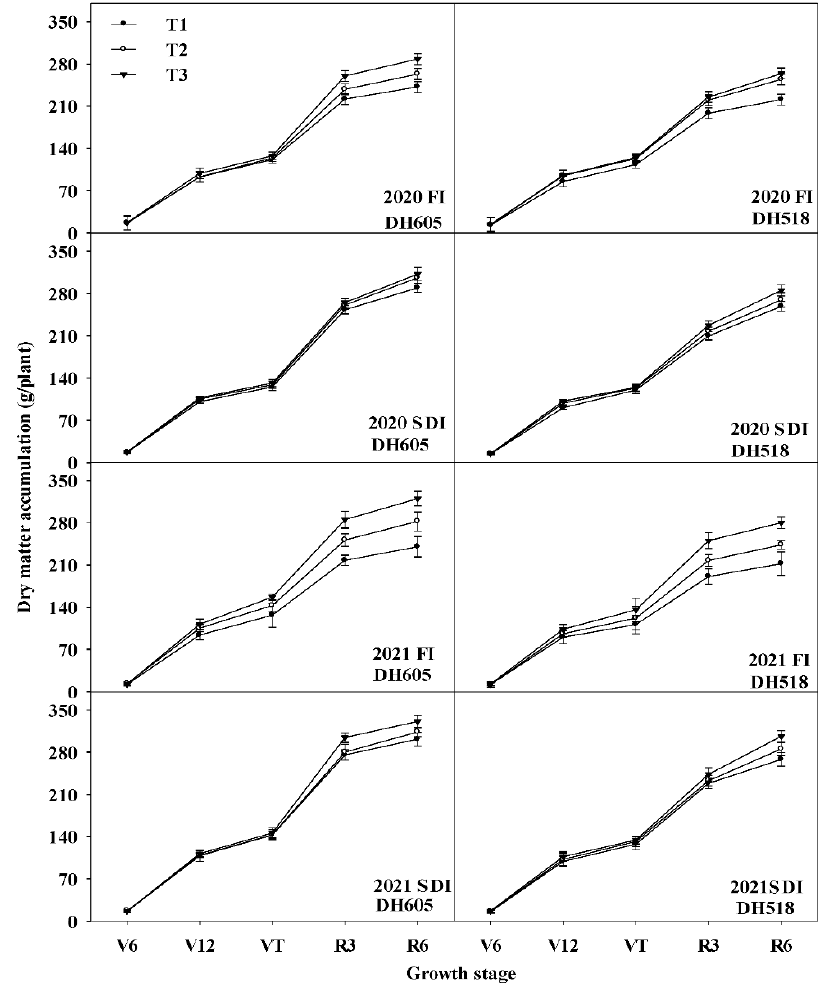
Figure 1. Effects of different irrigation treatments on dynamic changes in plant dry weight at different growth stages of two corn hybrids differing in maturity.